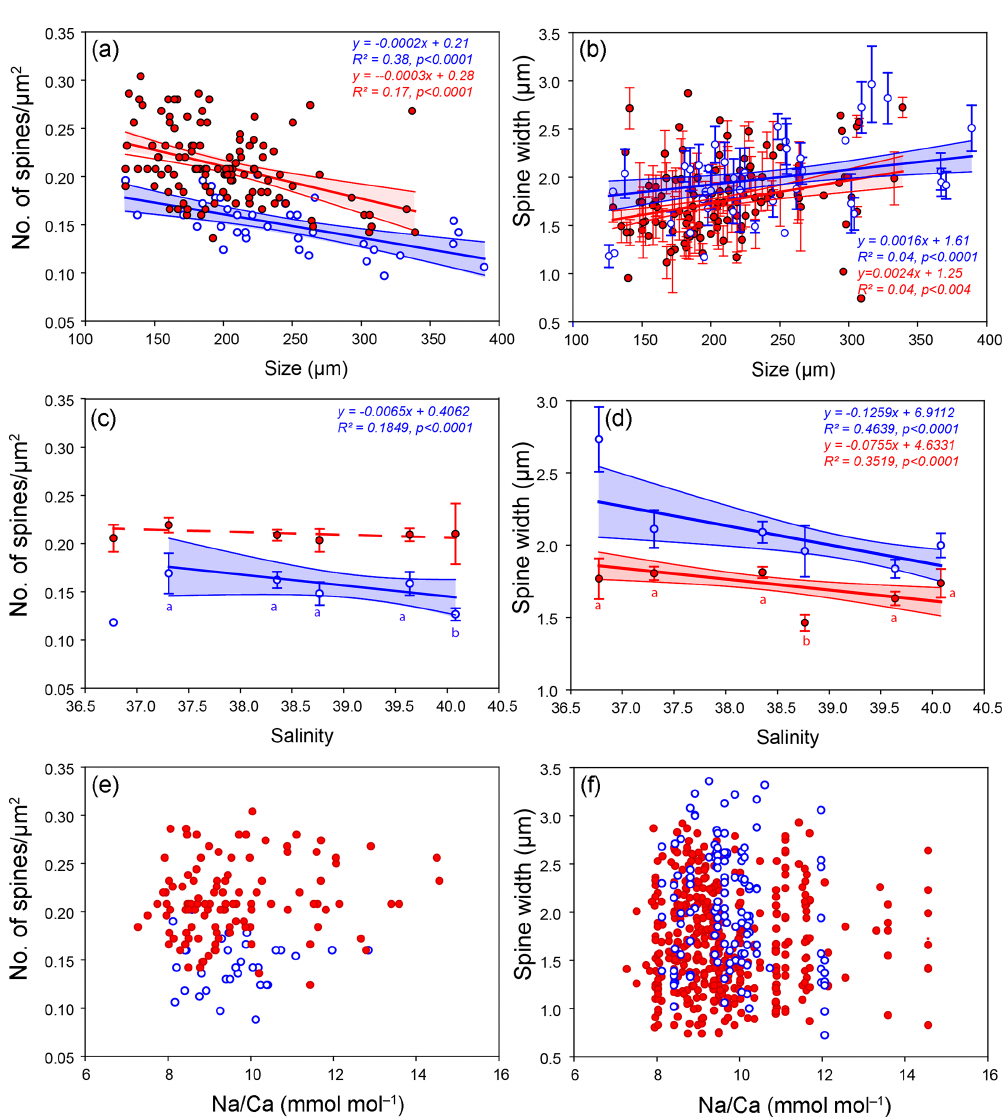
Figure 4. Results from the SEM spine density and width counts for G. ruber (red closed circles) and T. sacculifer (blue open circles) specimens, with standard errors indicated and enveloped into a 95% certainty interval, with (a) number of spines versus the size (µm) of the foraminiferal specimen these were counted on, (b) spine width (µm) versus the size (µm) of the specimen these were counted on, (c) number of spines versus salinity, (d) spine width versus salinity, (e) number of spines and the measured whole-shell Na / Ca composition and (f) spine width versus the measured whole-shell Na / Ca